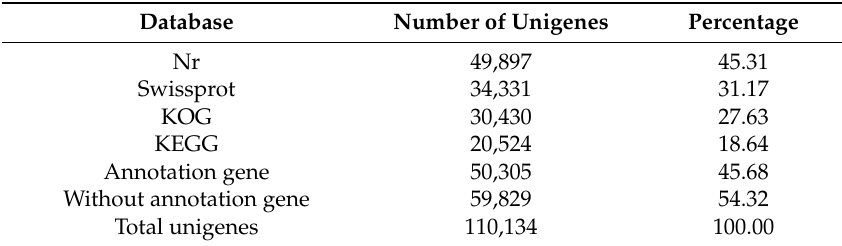
Table 1. Functional annotation of the kiwifruit